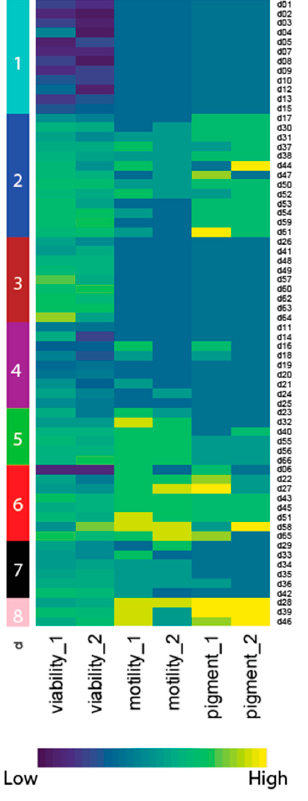
Figure 4. Comparative heat-map of hits displaying scaled readouts for viability, motility, and pigmentation is shown (two duplicates for each drug and two different batches of larvae, “1” and “2” were used). Viability: 40 iL3 per well were incubated with compounds of interest at 100 µM for 4 days. After 72 h, Sytox Green was added to the culture and viability was acquired by spectrophotometric measurement 24 h later. Motility: compounds with an effect that was greater than that obtained for the reference compound (QND) were further scored for motility under bright-field microscopy. Pigmentation: Compounds with an effect that was greater than that obtained for the reference compound (QND) were also scored under bright-field microscopy for the presence/degradation of a hemozoin-like compound. All measurements were performed in the same experiment. Values were Z-scored for each readout (centred of the mean of the data), negative Z-scores (lower fitness) are shown in dark blue, and positive Z-scores (higher fitness) are shown in yellow. Clusters are shown on the left and numbered 1–8.